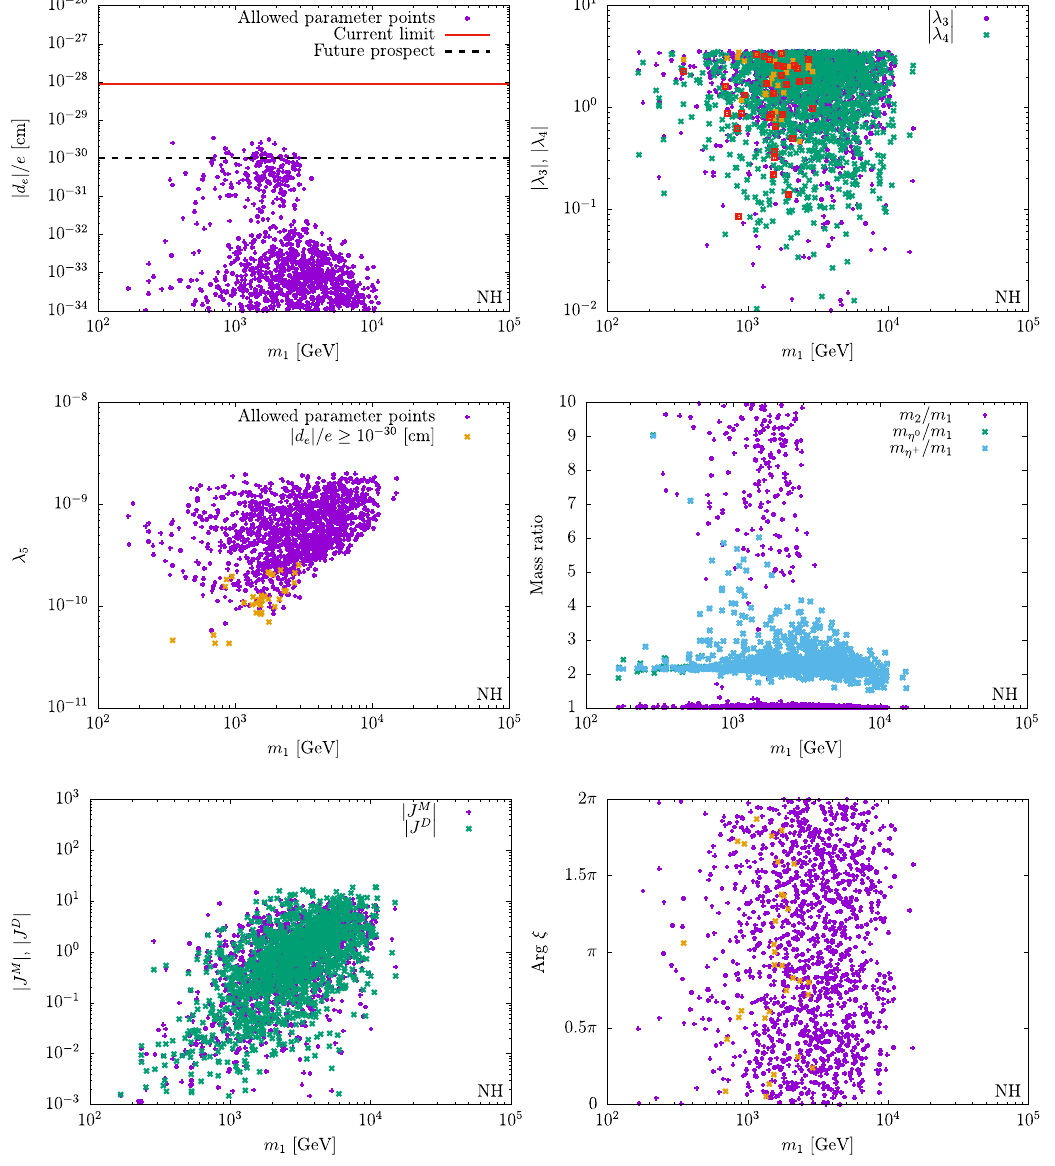
Figure 4 . Numerical results for fermionic dark matter in the case of normal hierarchy for the light neutrino spectrum. Each point complies with all the constraints discussed in section